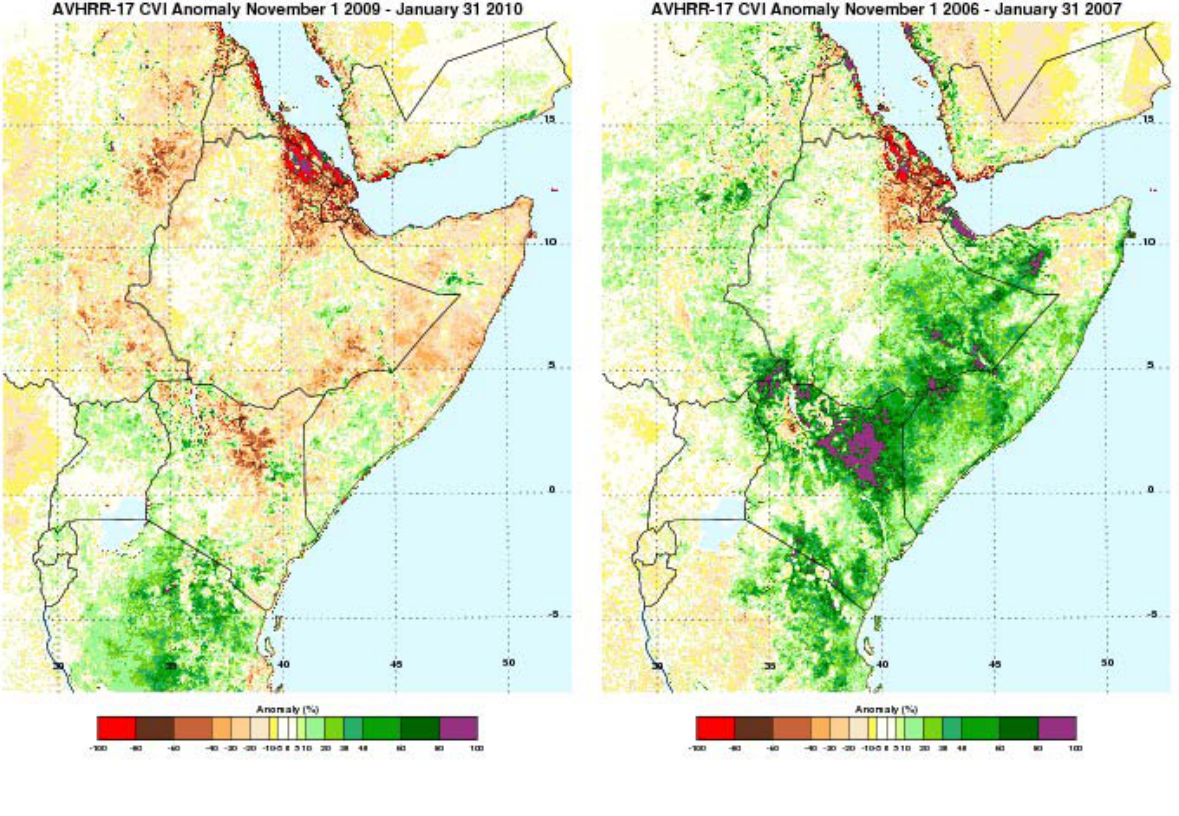
Figure 8. Example of November to January CVI anomaly for East Africa. Left: 2006–2007 season, the most recent wetter than average season. Right: 2009–2010, the current seasonal CVI